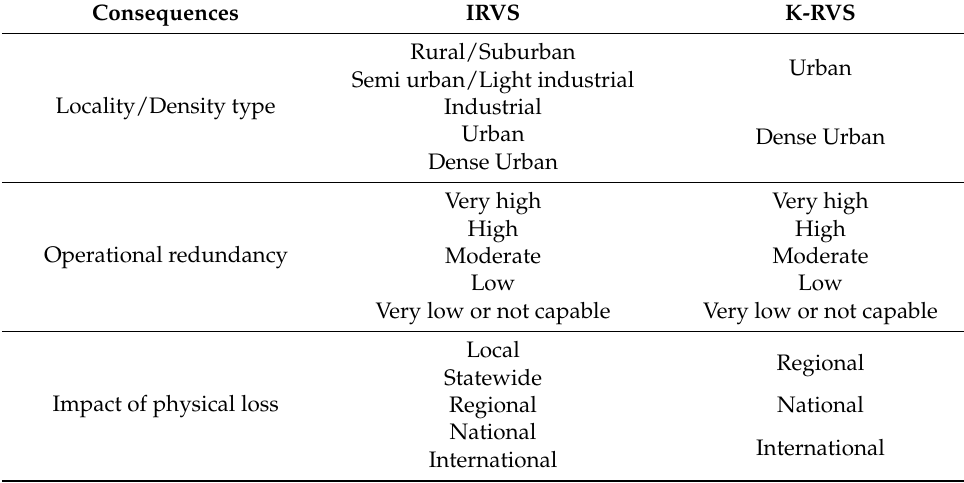
Table 4. Comparison table for consequences between IRVS and K-RVS.